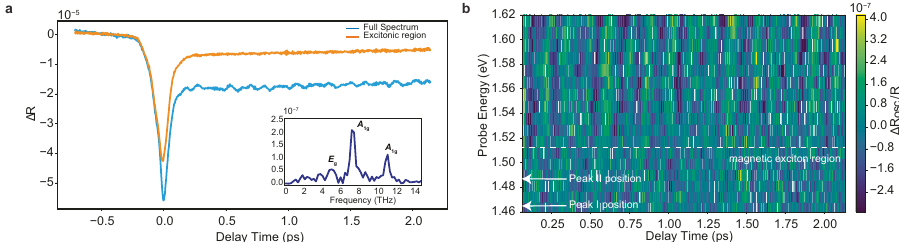
Fig. 3 Phonon modulates spectral region near d – d transition. a Coherent phonon spectroscopy traces were obtained below the Néel temperature (77 K), with ~25 fs temporal resolution. The blue trace represents the energy integrated coherent phonon spectroscopy trace. The oscillatory part of the energy integrated transient re fl ectivity was extracted after subtracting an exponential background from the raw data. Energy integrated coherent phonon spectroscopy reveals three distinct high-frequency optical phonons at 5.2, 7.5, and 11.5 THz. The Fourier amplitudes of the oscillations are shown in the inset. The orange line represents the data obtained with a long pass fi lter (cut-off energy: 1.53 eV) that excludes the d – d level transition. This spectrally separates the spin – orbit-entangled exciton from d – d levels. The 7.5 THz phonon mode modulates the d – d transition region, whereas the region with excitons is not being modulated by this mode. b Energy-resolved coherent phonon spectroscopy. For fi ner energy resolution, the probe beam was sent to a monochromator and coherent phonon oscillations in the energy region between 1.46 and 1.62 eV, was measured. The data clearly shows that the modulations are mainly present in the spectral region near the d – d